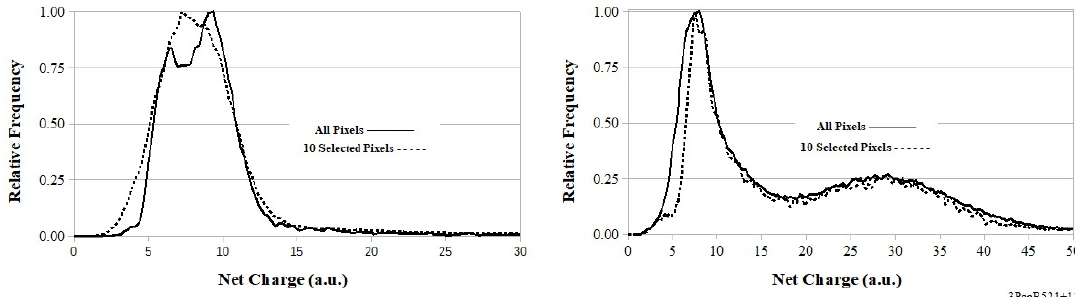
Figure 10. Co-57 ( left ), and Ba-133 ( right ) data: comparison between the pulse-height spectra from All pixels and the ones from the respective selected decuples of pixels. Spectra were normalized to the respective maximum values.